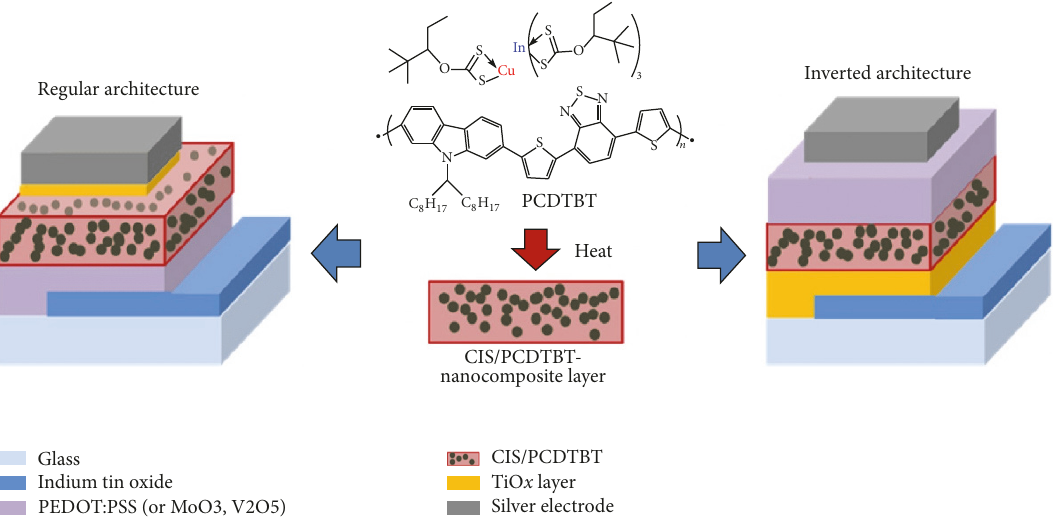
Figure 9: Schematic illustration of the regular and inverted device architectures and the in situ route using metal xanthates as precursors for the formation of metal sulfide nanocrystals directly in polymer matrices [143].